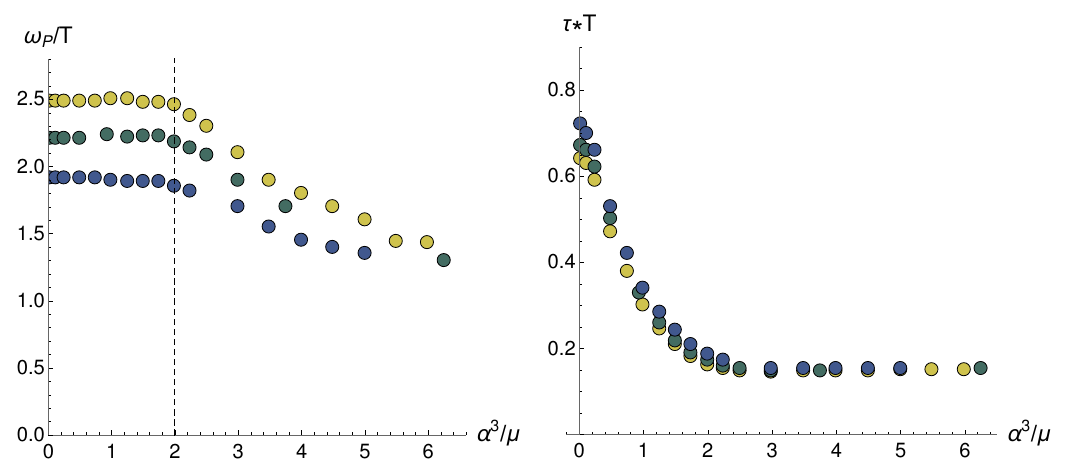
Figure 13 . The e(cid:11)ective relaxation scale (cid:28) and the plasma frequency ! p in function of the dimen- sionless SSB strength (cid:11) 3 =(cid:22) for (cid:21) = 0 : 8 ; 1 ; 1 : 2 (blue-yellow). All points are at (cid:22)=T = 4.